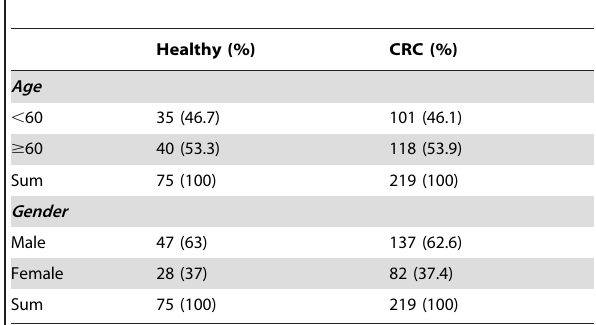
Table 1. The demographics of 75 healthy control subjects and 219 colorectal cancer patients according to age and